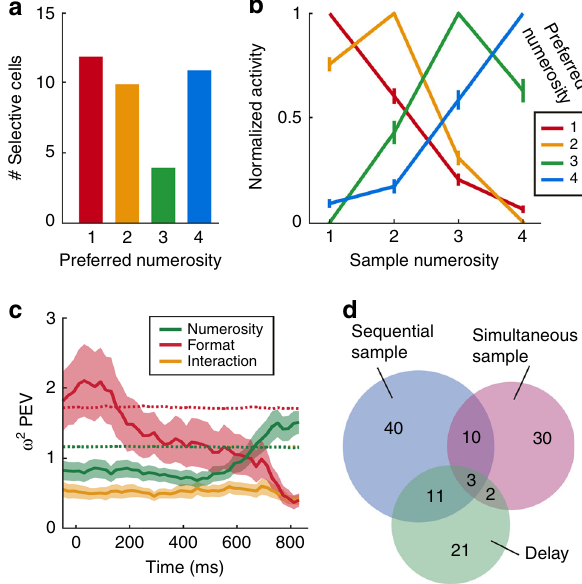
Fig. 5 Characterization of neuronal responses during the delay. formats. b Average normalized tuning curves for all delay neurons preferring the same numerosity (error bars ± SEM). c Effect size ( ω 2 percent-explained variance) of numerosity and presentation format (sequential vs. simultaneous) on fi ring rates over time of numerosity- selective delay neurons ( n = 37). Time point 0 ms is delay onset. Shading signi fi es ±SEM. Dashed lines indicate signi fi cance thresholds (95th percentile of shuf fl ed distribution); the “ interaction ” threshold is superimposed by the “ numerosity ” threshold. d Venn diagram illustrating the distribution of numerosity-selective neurons across task phases. All error bars indicate